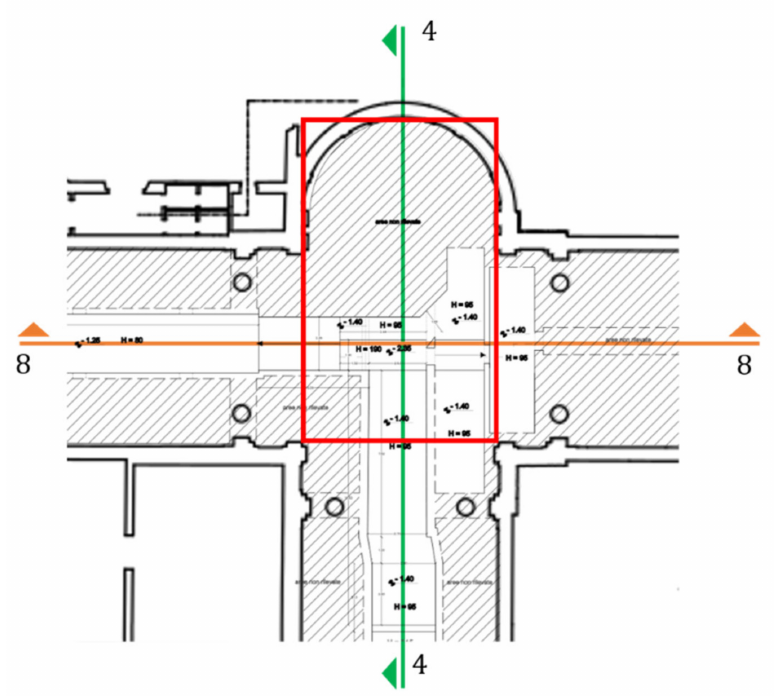
Figure 2. Plan view of the “Tribuna” with the underground corridors for the air-conditioning system.